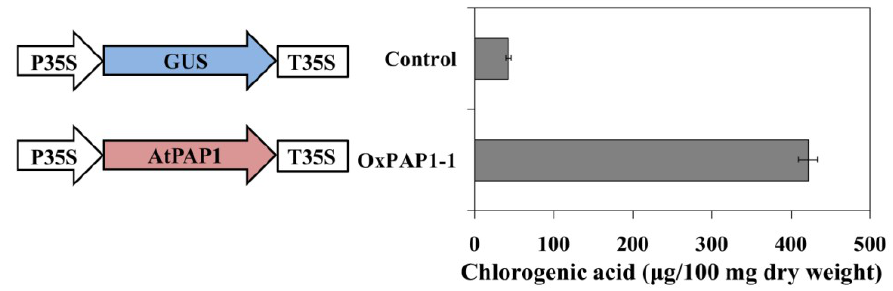
Figure 5. Chlorogenic acid content in P. grandiflorum hairy roots transformed with AtPAP1 over-expression constructs. The height of each bar and the error bars show the mean and standard error, respectively, of three independent measurements. P35S, CaMV 35S promoter; T35S, 3' termination signal of CaMV 35S